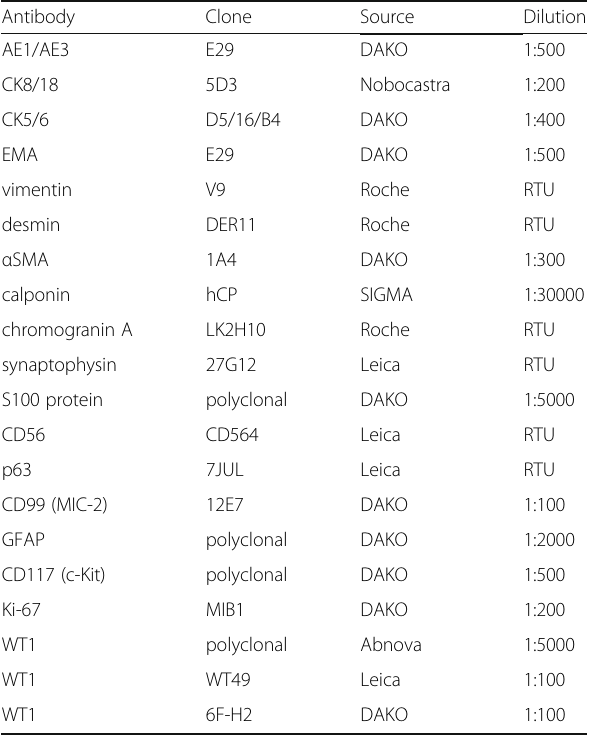
Table 1 List of Antibodies Antibody